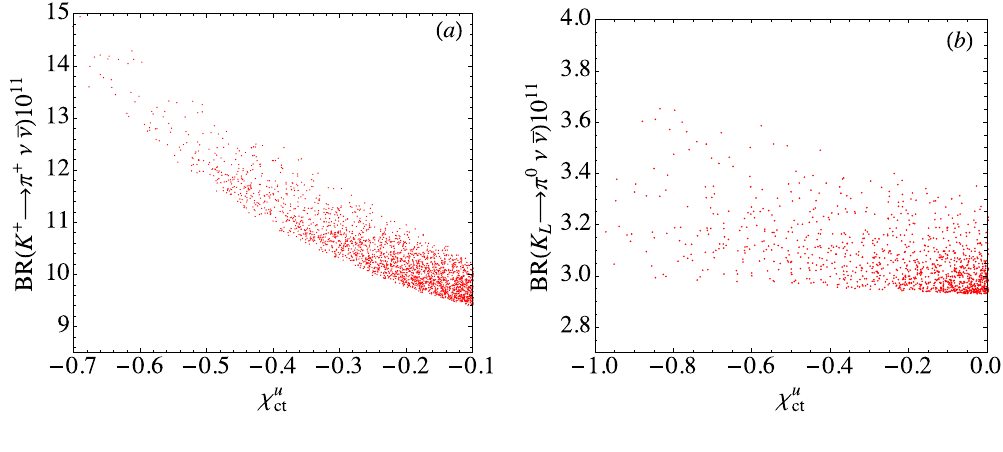
Figure 9 . (a) BR ( K +